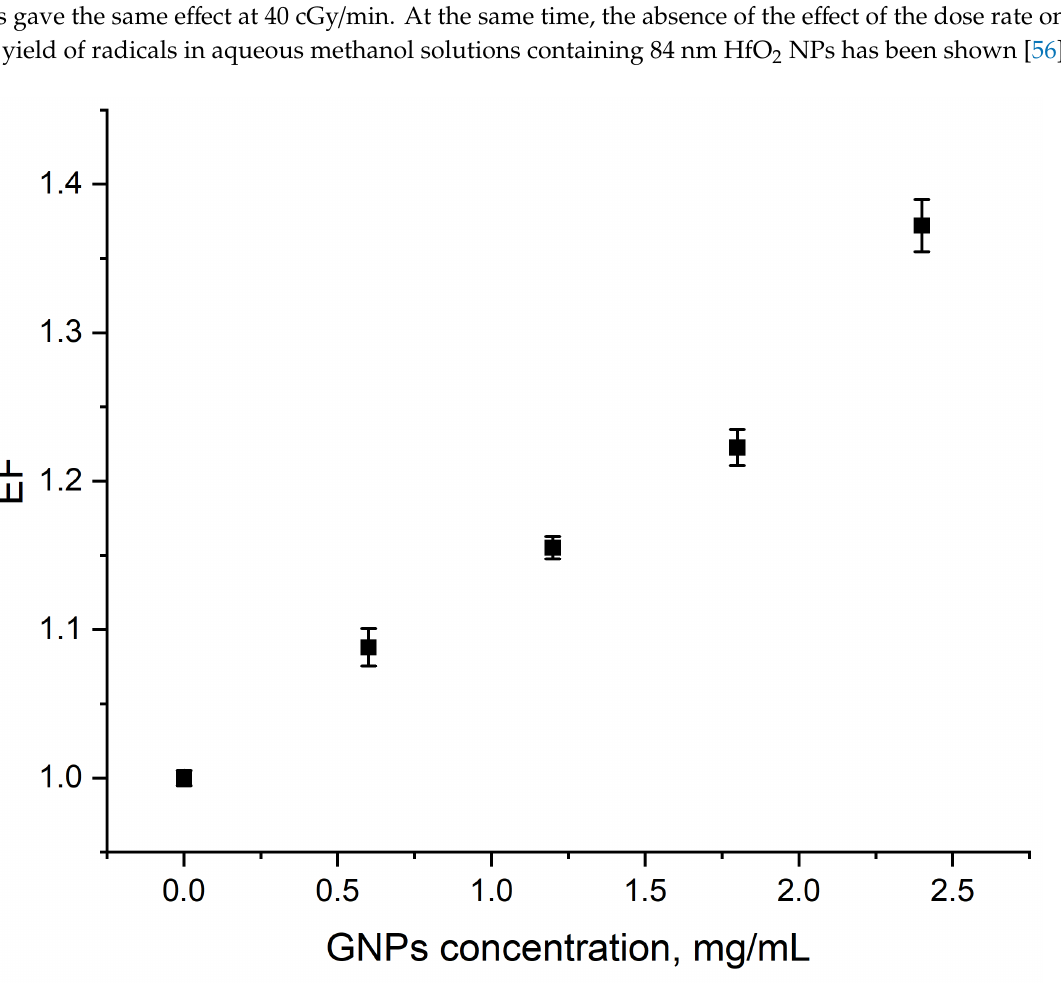
Figure 5. Dependence of enhancement factor (EF) on the concentration of 26 nm GNPs (5 Gy, 200 kVp, 0.2 Gy / min). The GNP:DNA ratio in the samples ranged from 0.075 to 1.5 particles per one DNA molecule. Error bars are mean confidence intervals calculated by three parallel independent measurements for α =